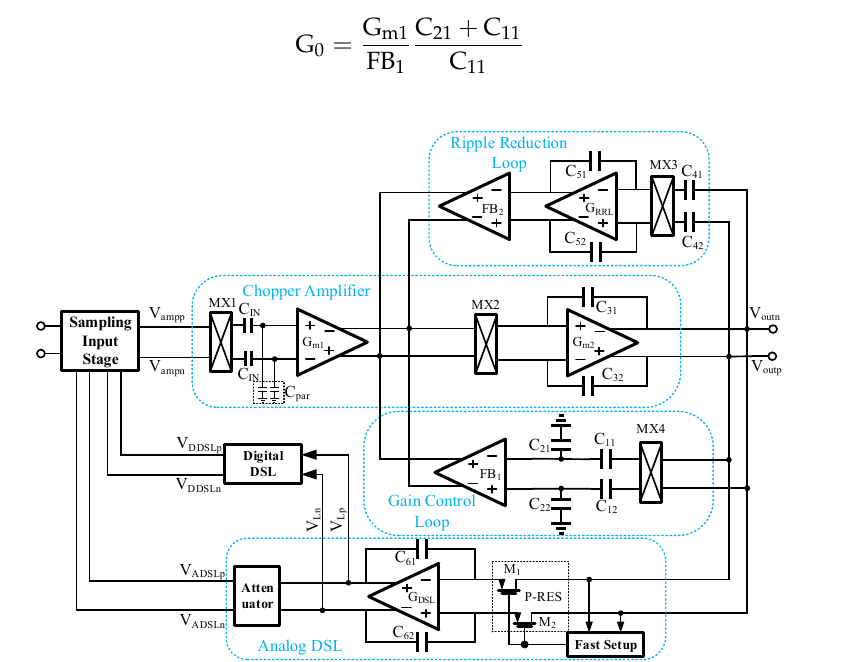
Figure 1. System diagram of the proposed digital-analog hybrid offset suppression electrocardiogram (ECG) amplifier.